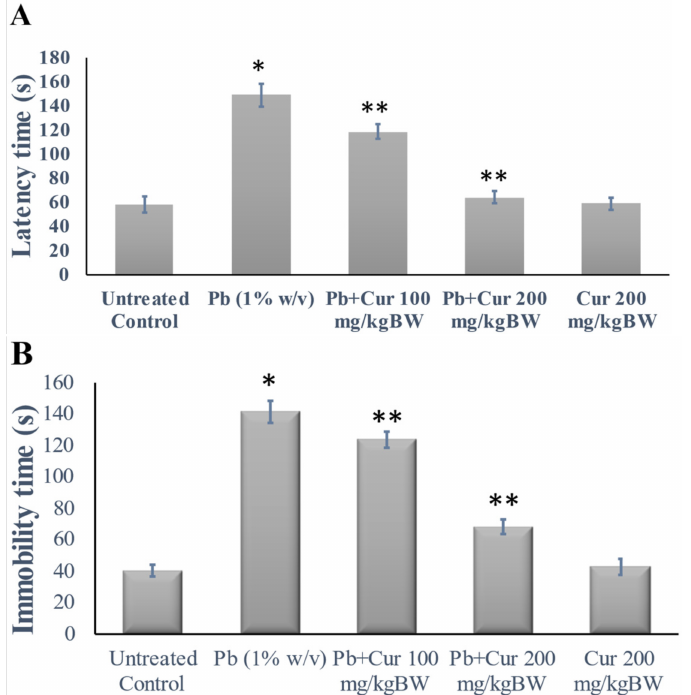
Figure 1. Effect of curcumin on cognitive dysfunction caused by Pb. ( A ) Curcumin’s effect against memory loss and learning deficit of mice as related to latency time (s) using the Morris water maze swimming test. ( B ) Curcumin’s effect against depression-like behavior of mice as related to the immobility time (s) using the forced swimming Test. The results are displayed as mean ± SEM ( n = 6). * p < 0.05 specifies a difference between control mice and Pb-treated mice. ** p < 0.05 compares Pb-treated mice and curcumin (Cur)-treated